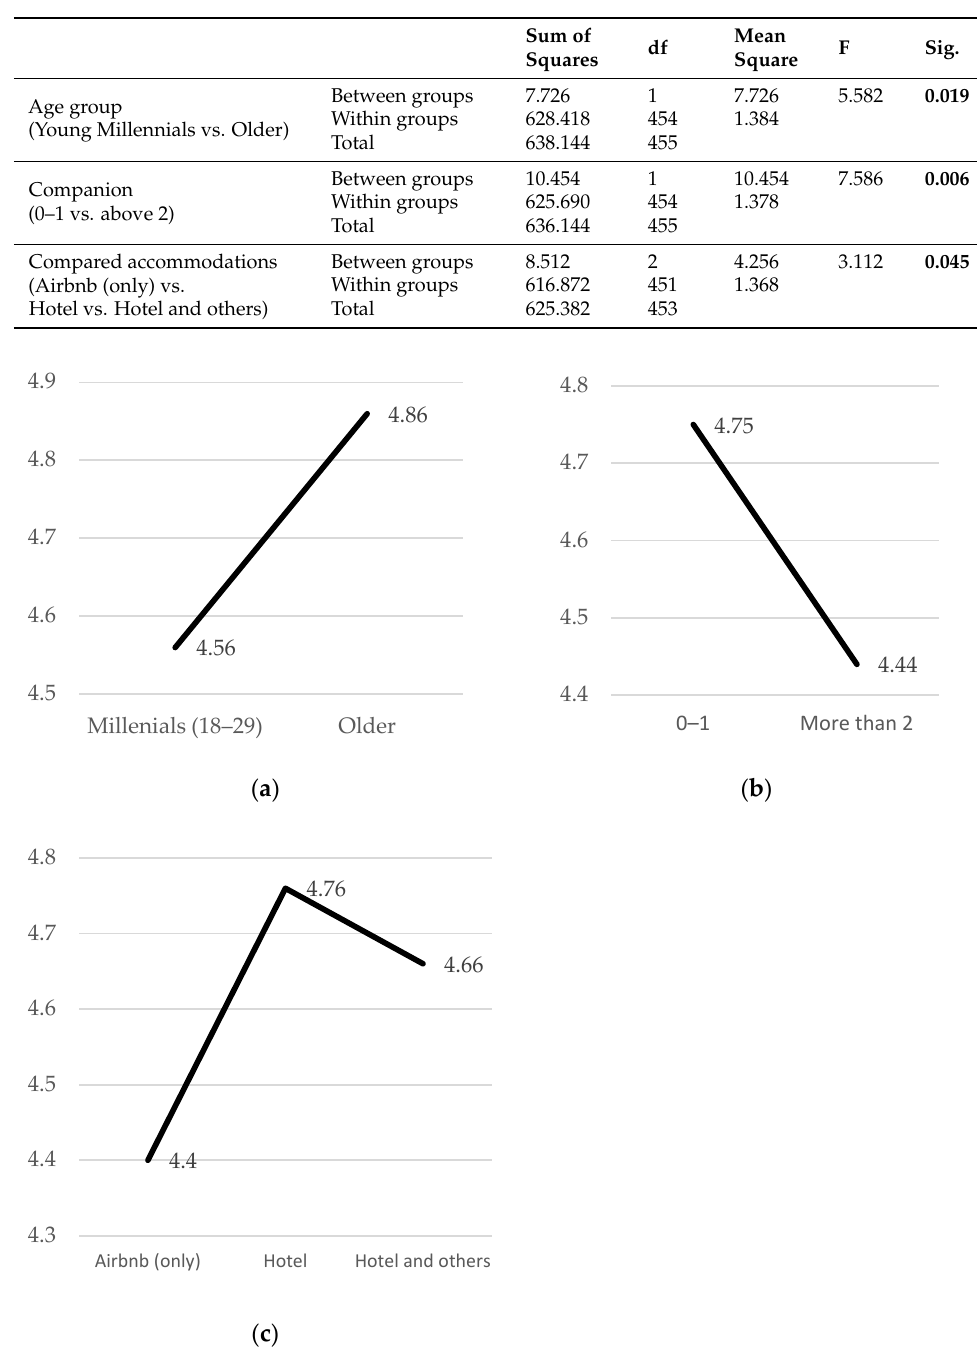
Table 8. The result of ANOVA.